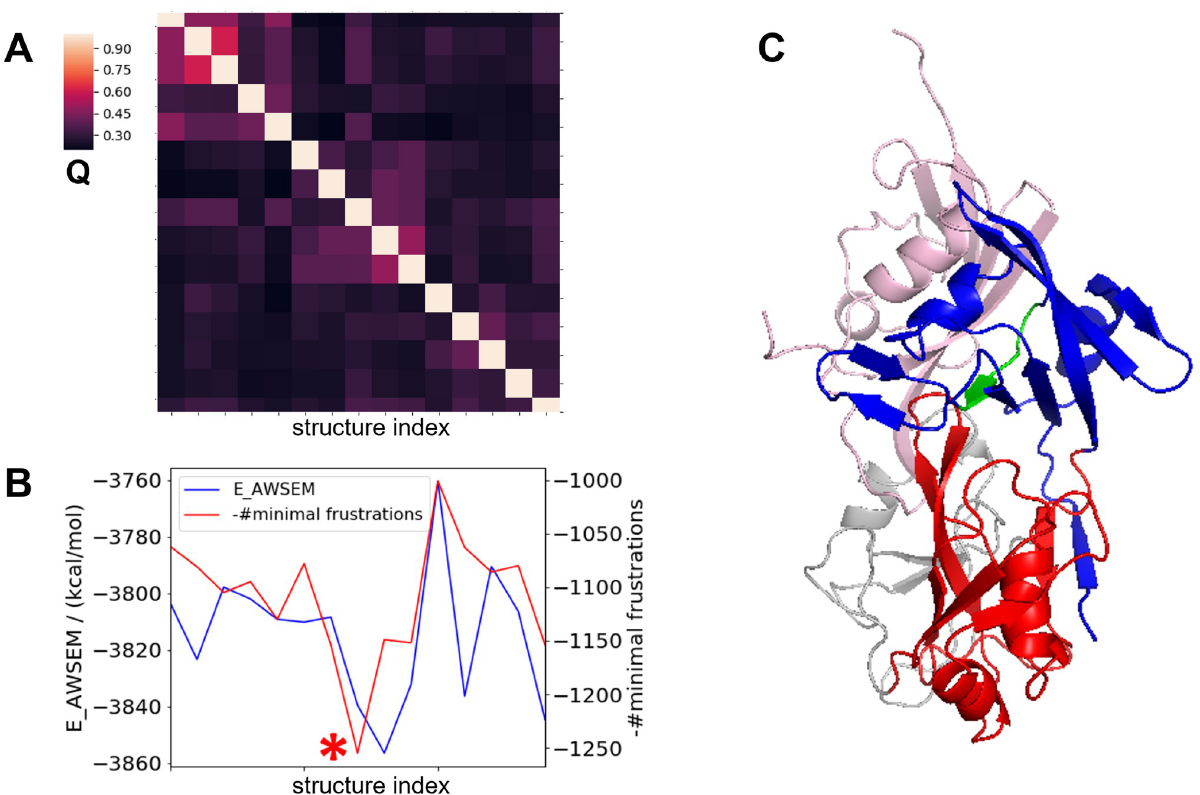
Fig 4. A . Clustering analysis for the predicted structures of the SUMO2/RBD complex using mutual Q (including inter-domain and inter-molecular residue pairs) as the structural similarity metric. B . Potential energy (blue line) and numbers of minimally frustrated contacts (red line) for the predicted SUMO2/RBD complex structures. The structure with the largest number of minimally frustrated contacts and having relatively low potential energy is selected as the representative structure (marked with a red star) and is shown in Fig 4C. C . The predicted structure of the SUMO2/RBD complex. The SUMO2 is colored in pink and the SIM in RRM1 is colored in